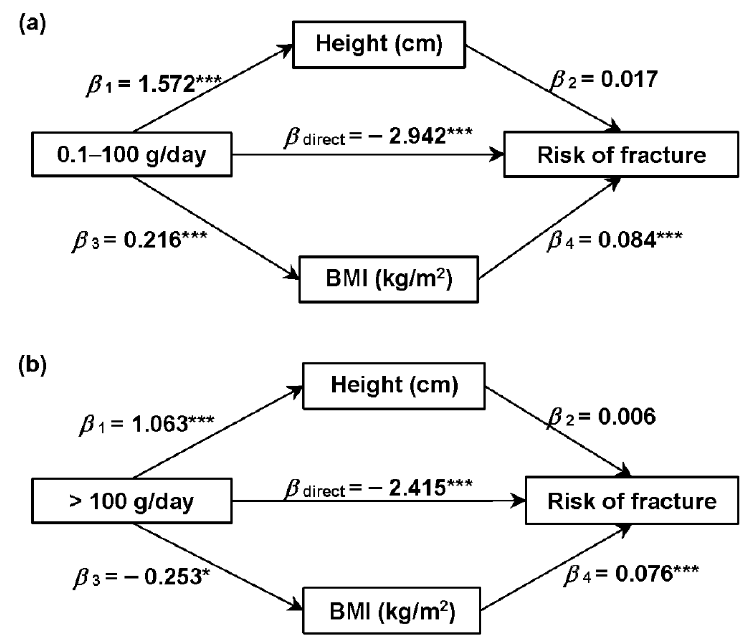
Figure 3. Mediation effect of height and BMI on the association of dairy product intake of ( a ) 0.1–100 g/day and ( b ) >100 g/day with the risk of fracture compared to no consumption of dairy products. Data are regression coefficients with adjustment for covariates (including age, sex, educational level, region of residence, individual annual income, smoking history, drinking history, chronic disease history, physical activity, and intakes of total energy and total calcium). * p < 0.05, *** p < 0.001.